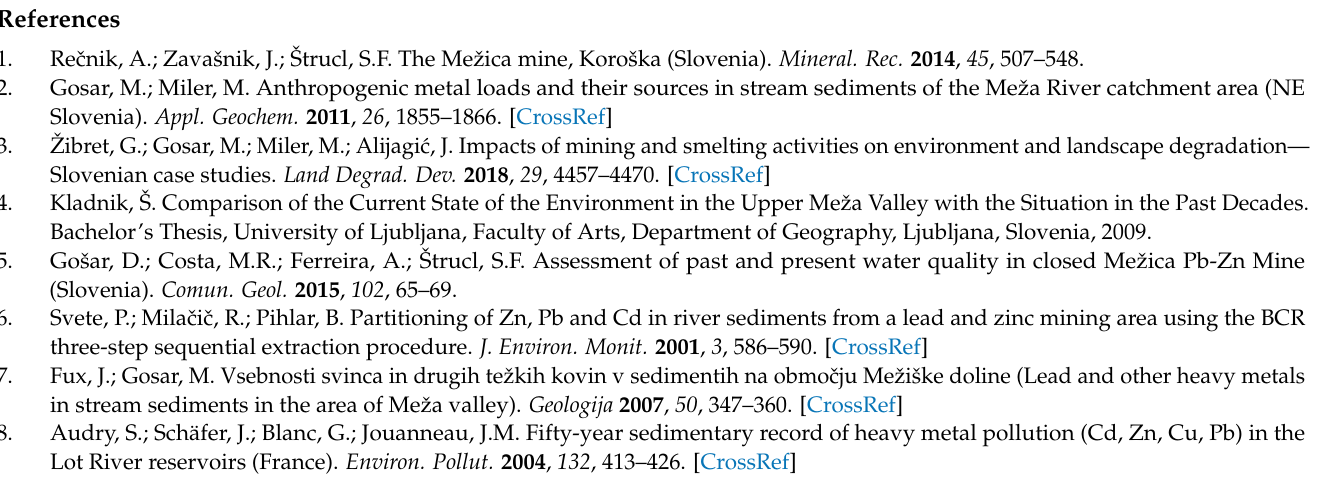
Figure S3: Pb isotopic composition of two different fractions of sediment samples from the Meža River and its tributaries shown on a biplot of 208Pb/204Pb with 206Pb/204Pb; Figure S4: Pb isotopic composition of two different fractions of sediment samples from the Meža River and its tributaries shown on a biplot of 208Pb/206Pb with